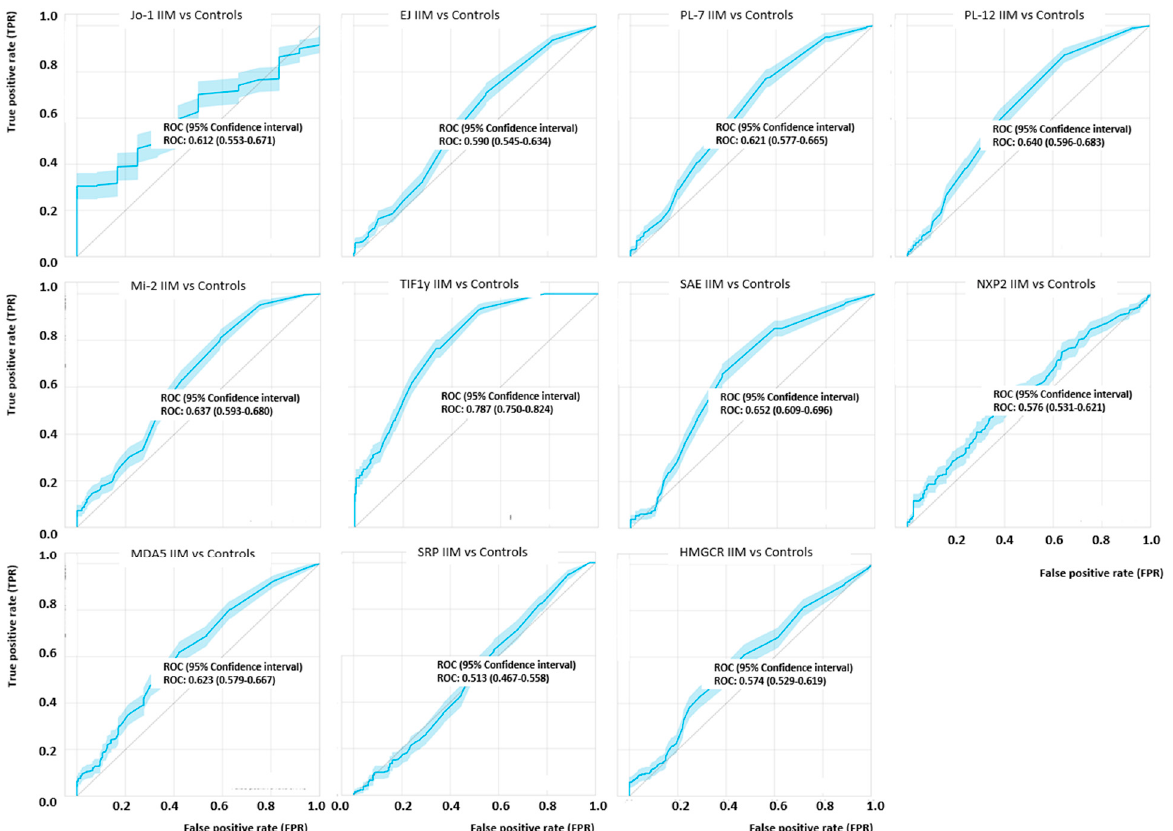
Figure 2. Receiver operating characteristic (ROC) analyses of myositis specific antibodies in idiopathic inflammatory myopathy (IIM) patients and controls. The ROC curves show variable discrimination between IIM and controls with significant discrimination only for Jo-1 and TIF1 γ . Antibodies such as anti-EJ, anti-Mi-2, anti-MDA5 and anti-HMGCR showed good discrimination only in the low sensitivity part of the ROC curve which is linked to the different phenotypes combined in the analyses. The area under the curve (AUC) values are summarized in the